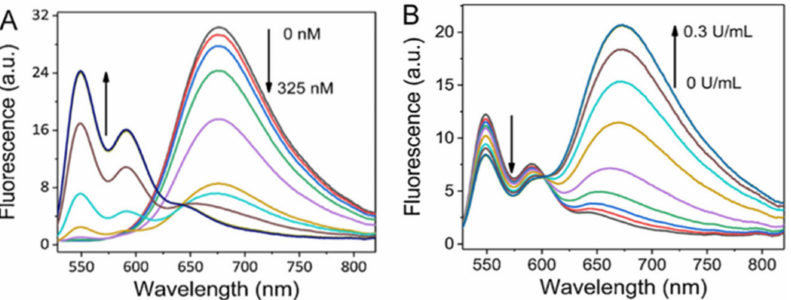
Figure 28. Fluorescence spectra of probe 10 in the presence of MUTAB-Ag NPs (29.4 ± 3.6 nm) with heparin (0–325 nM) ( A ) and with heparinase (0–0.3 U/mL) ( B ) [75].